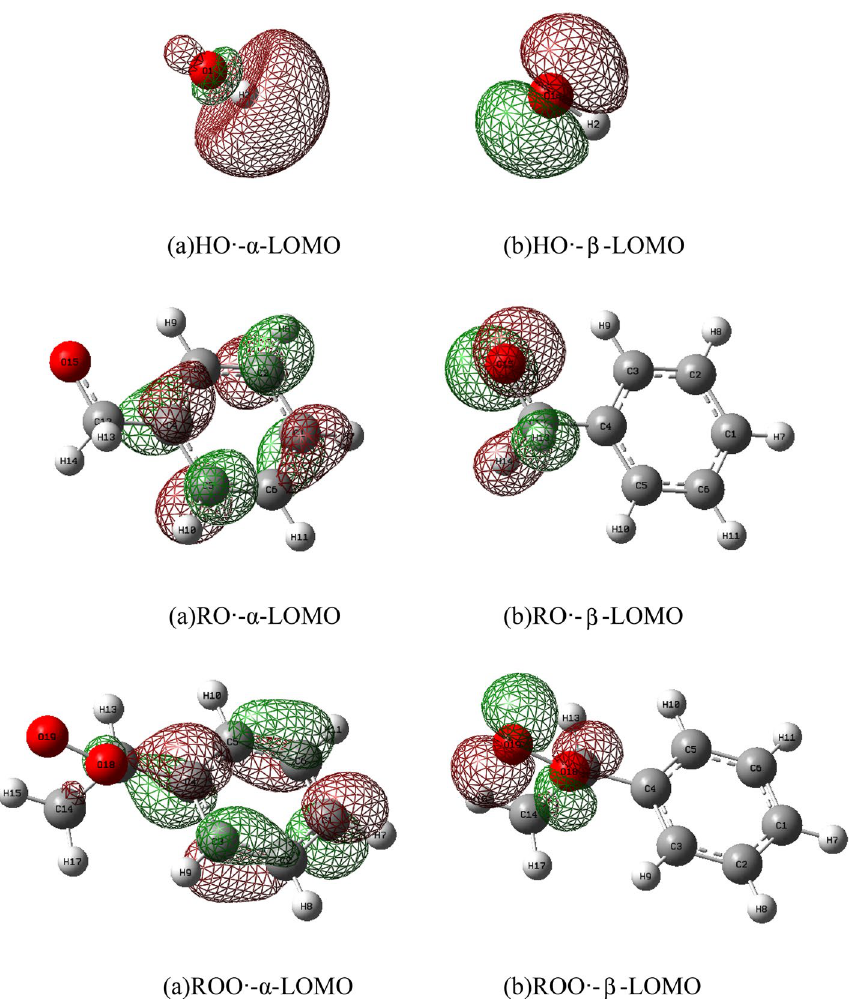
Figure 8. α-LOMO and β-LOMO of free radicals.